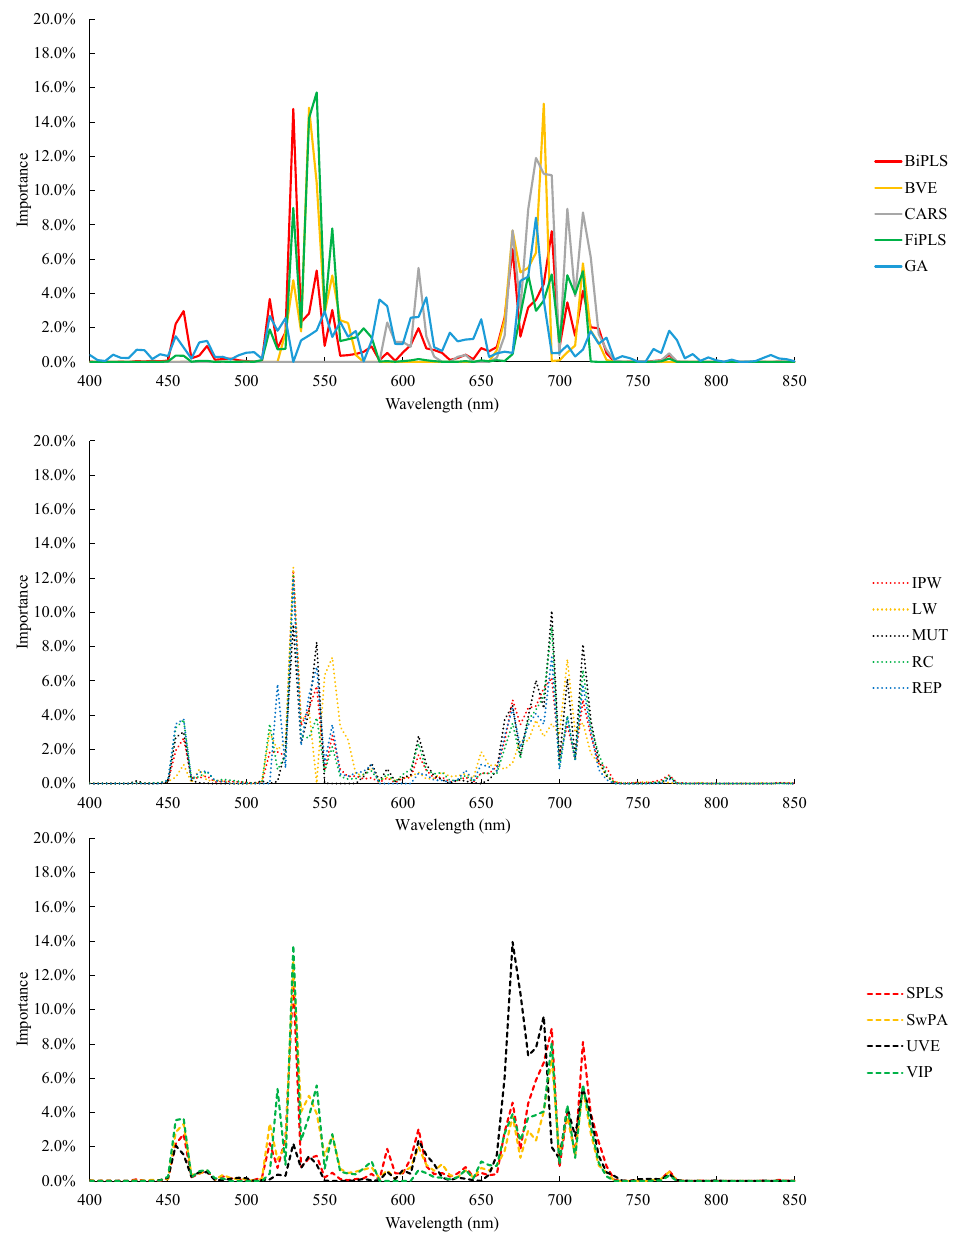
Figure 8. Sensitivity analysis of regression models based on Cubist for DT preprocessing combined with the 14 variable selection methods.